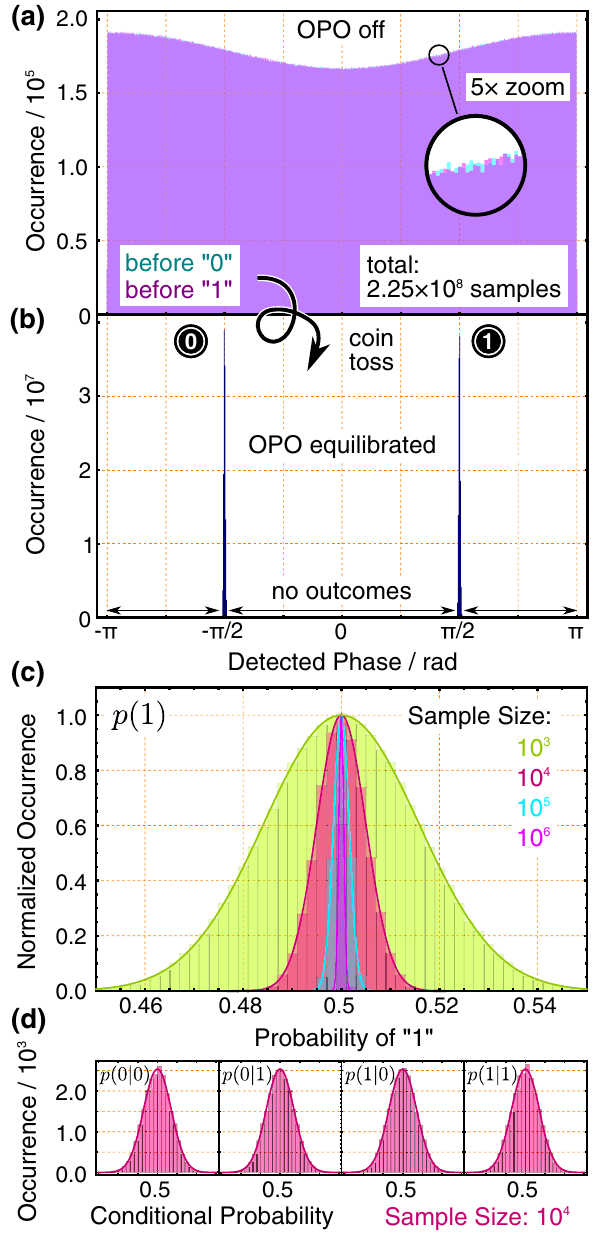
FIG. 3. Analysis of the raw bits. (a) Measurement outcomes when the OPO is off. Essentially, all different phases are randomly measured, with a small bias. (b) Measurement out- comes, after the OPO is equilibrated in the P2 state. (c) Probability to find a 1 as the outcome for different sample sizes N . Note that the solid curve is the predicted result and not a fit. (d) Conditional probability for the different options of tuple outcomes. Range 0 . 47 to 0.53. These probabilities are the spans from p cond ¼ relevant key figures for the entropy estimation below. Total sample size for all of the above is 2 . 25 × 10 8